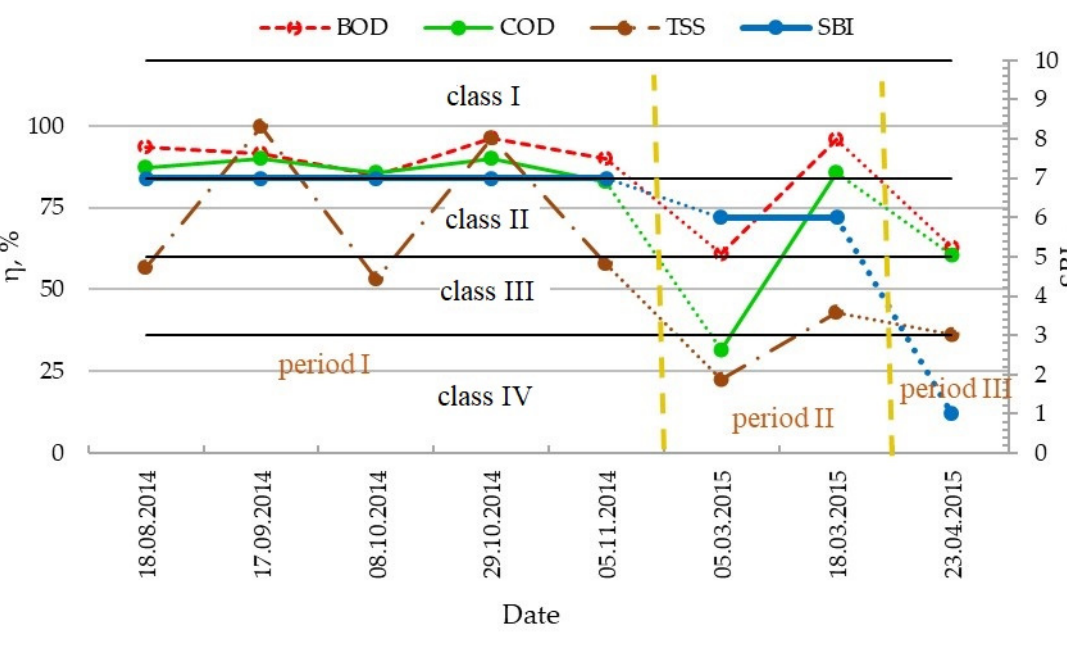
Figure 9. Sludge biotic index (SBI), efficiency of organic compounds (BOD 5 , COD) removal, and efficiency of total suspended solids (TSS) removal in WTP2.